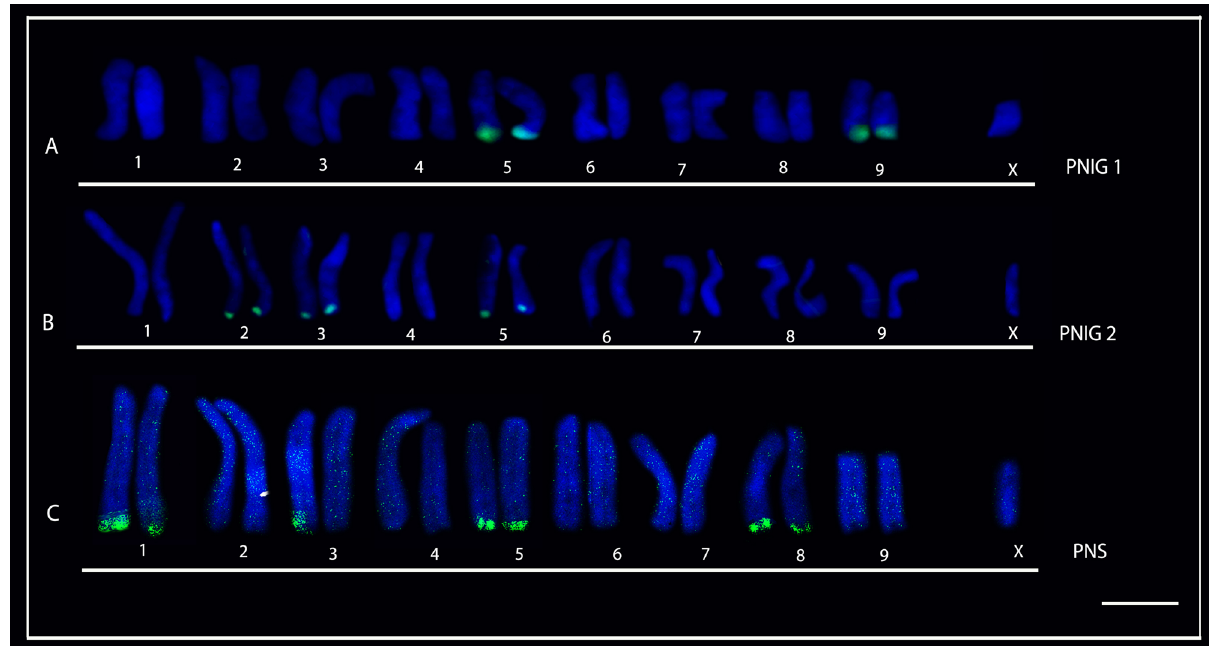
Figure 5 – Karyotypes of two populations of L. gr. nordenskjoldi submitted to fluorescent in situ hybridization (FISH) with 18S rDNA. ( A ) individual from the Ilha Grande National Park (PNIG) population with ribosomal sites in pairs 5 e 9; ( B ) individual from the PNIG population with ribosomal sites in pairs 2, 3 e 5; ( C ) Superagui National Park (PNS) population with sites of 18S rDNA in pairs 1, 3, 5 and 8; pair 3 shows marking in only one of the chromosomes. Bar = 10 μm.